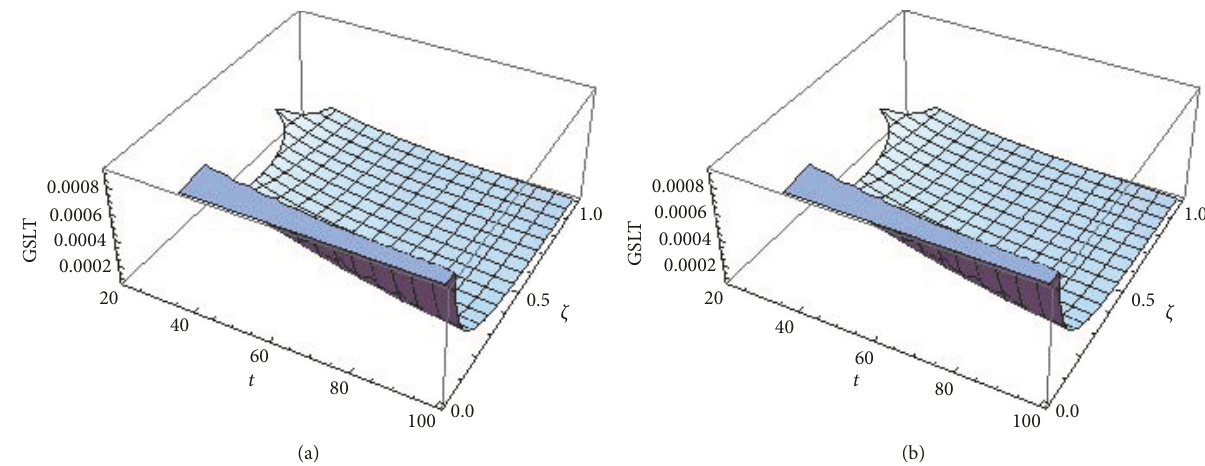
Figure 5: Validity of GSLT for the model (51). (a) is for 𝑑 1 = 𝑑 3 = 1 and (b) for 𝑑 1 = 1 and 𝑑 3 = −1 .